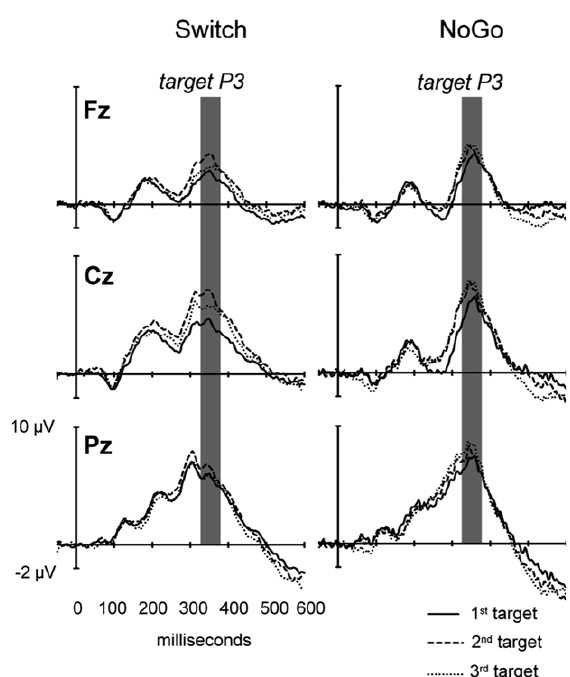
Figure 6. Target-locked ERPs to 3 consecutive targets trials in the Switch and NoGo tasks. Grand ERP waveforms elicited by the 1 st , 2 nd and 3 rd targets in a sequence of trials (with ‘ x ’ and ‘ + ’ trials collapsed). The data are shown from 3 midline electrodes (Fz, Cz, Pz). Gray bars indicate the latency window for measurement of mean target-locked P3 amplitudes.